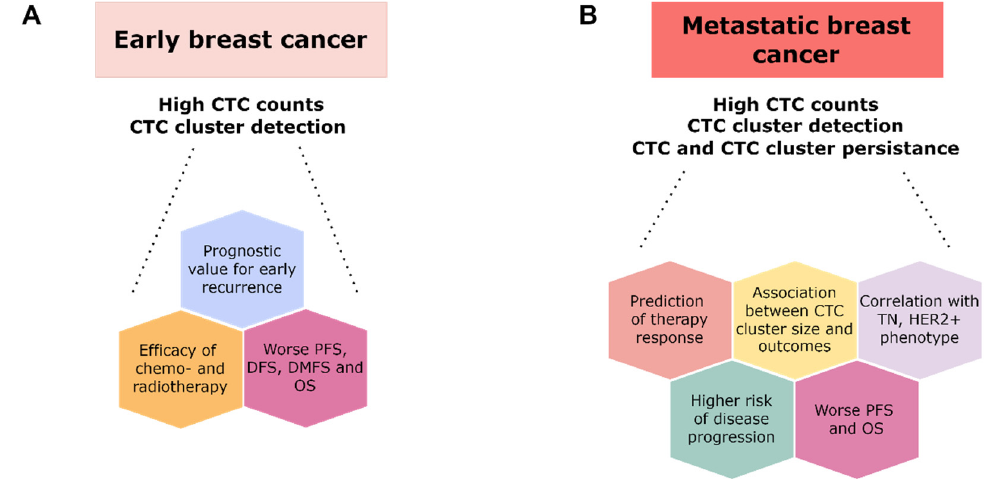
Figure 3. Clinical relevance of CTC and CTC cluster count and persistence evaluation utilized in patients with early ( A ) and metastatic breast cancer (MBC) ( B ). Mounting evidence regarding the clinical relevance of CTCs and CTC clusters comes from studies comprising MBC. Since the improvements in detection methods, an emerging role of CTCs and CTC clusters was documented in early BC, showing the correlations with early recurrence, treatment response, and patient outcomes. However, many associations are not clearly defined, and further research in large cohorts of early BC, as well as MBC, patients might help to clarify the real relationships. Abbreviations: CTC, circulating tumor cell; DFS, disease-free survival; DMFS, distant-metastasis-free survival; HER2+, human epidermal growth factor receptor 2 overexpressed; MBC, metastatic breast cancer; OS, overall survival; PFS, progression-free survival; TN, triple negative.